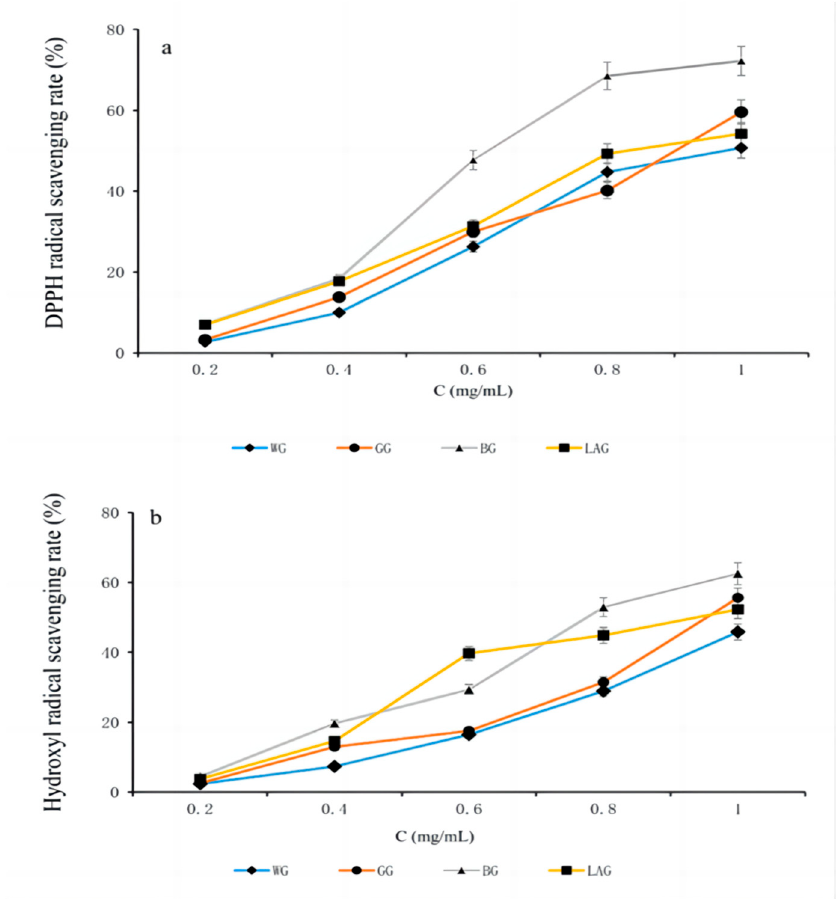
Figure 1. Antioxidant activities of WG, GG, BG and LAG. ( a ) DPPH scavenging activities; ( b ) hy ‐ droxyl radical scavenging activities. WG: white garlic; GG: green garlic; BG: black garlic; LAG: Laba garlic; and DPPH: 1,1 ′‐ diphenyl ‐ 2 ‐ picrylhydrazyl. and DPPH: 1,1 (cid:48)